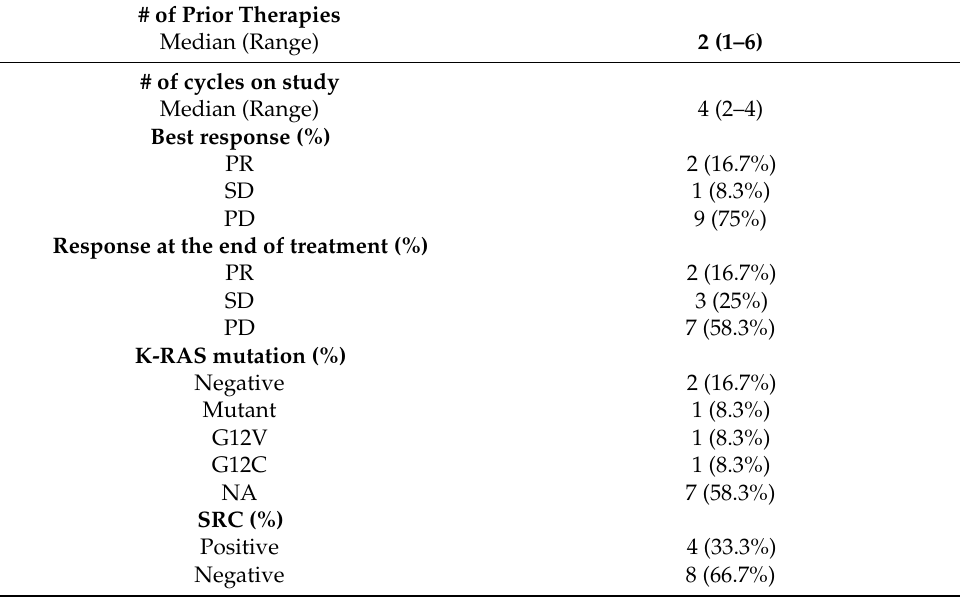
Table 2. Clinical outcome of patients included in the